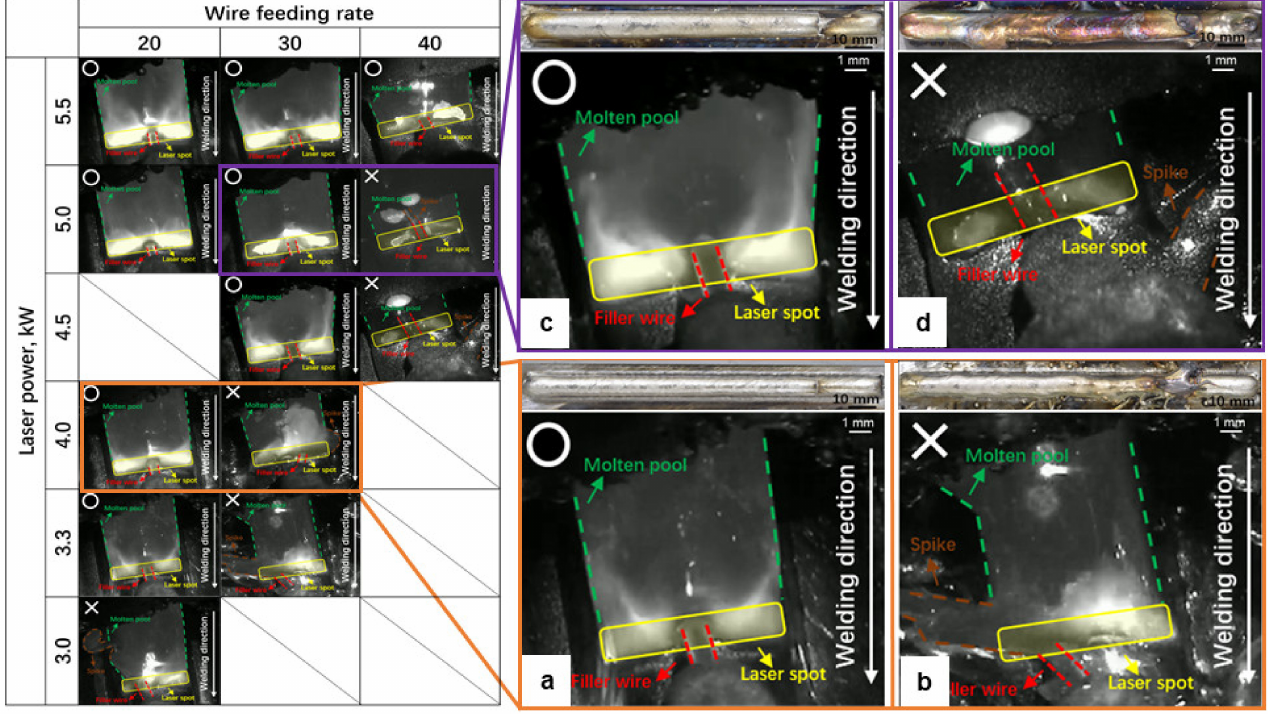
Figure 15. High-speed images during processing for various combinations of wire feeding rate and laser power using fixed process speed of 0.3 m/min: ( a ) P = 3.3 kW, WFR = 20, ( b ) P = 3.3 kW, WFR = 30, ( c ) P = 4.5 kW, WFR = 30, and ( d ) P = 4.5 kW, WFR =